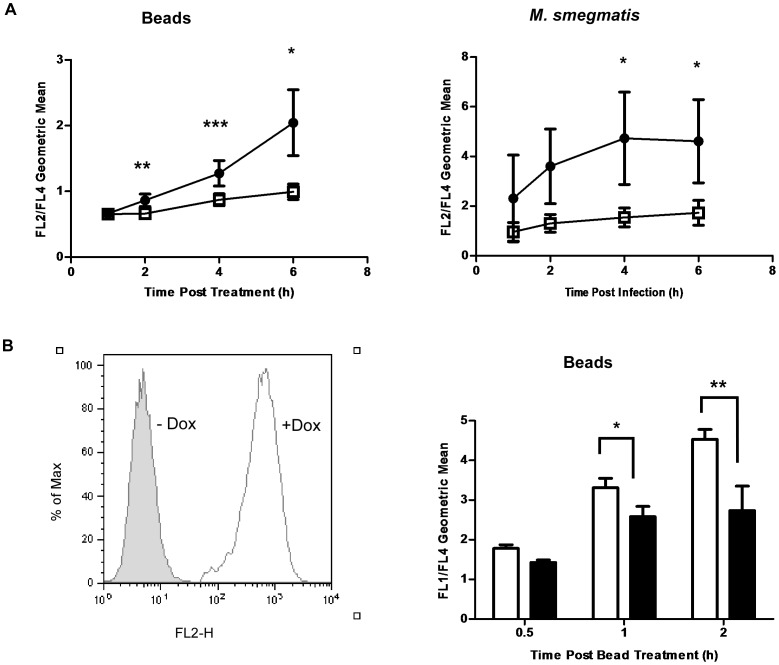
Delivery of the lysosomal enzyme β- galactosidase is impaired in p110α knockdown cells.
A) Knockdown of p110α results in decreased acquisition of the lysosomal enzyme β- galactosidase by phagosomes containing either BSA coated beads or M. smegmatis. Cells were fed prey that had been previously surface labelled with Alexafluor 633-SE and the fluorescent β-galactosidase substrate, C12RG. Cleavage of C12RG releases fluorescence which is read in the FL2 channel of the flow cytometer. This was then normalized to the Alexafluor 633 signal (FL4) for phagocytic uptake. Solid circles  =  control cells, empty squares  =  p110α knockdown cells. Timepoints were taken at 1 hour, 2 hours, 4 hours, and 6 hours post bead treatment or infection. *p<0.05, **p<0.001, **p<0.0005. Data are means +/− s.e.m., from at least four independent experiments. B) Inducible p110α knockdown via a distinct shRNA sequence also showed defects in β-galactosidase acquisition. Knockdown was induced by doxycycline treatment prior to experimentation, which also induces expression of TurboRFP which is linked to shRNA production. The histogram on the left shows induction of red fluorescence when cells were given doxycycline. Cells were also fed the green fluorescent β-galactosidase substrate, C12FDG, which is read in the FL1 channel. Empty bars  =  Control cells (no doxycycline induction), Solid bars  =  Cells induced for p110α knockdown. *p<0.05, **p<0.001. Data are means +/− s.e.m. from five independent experiments.